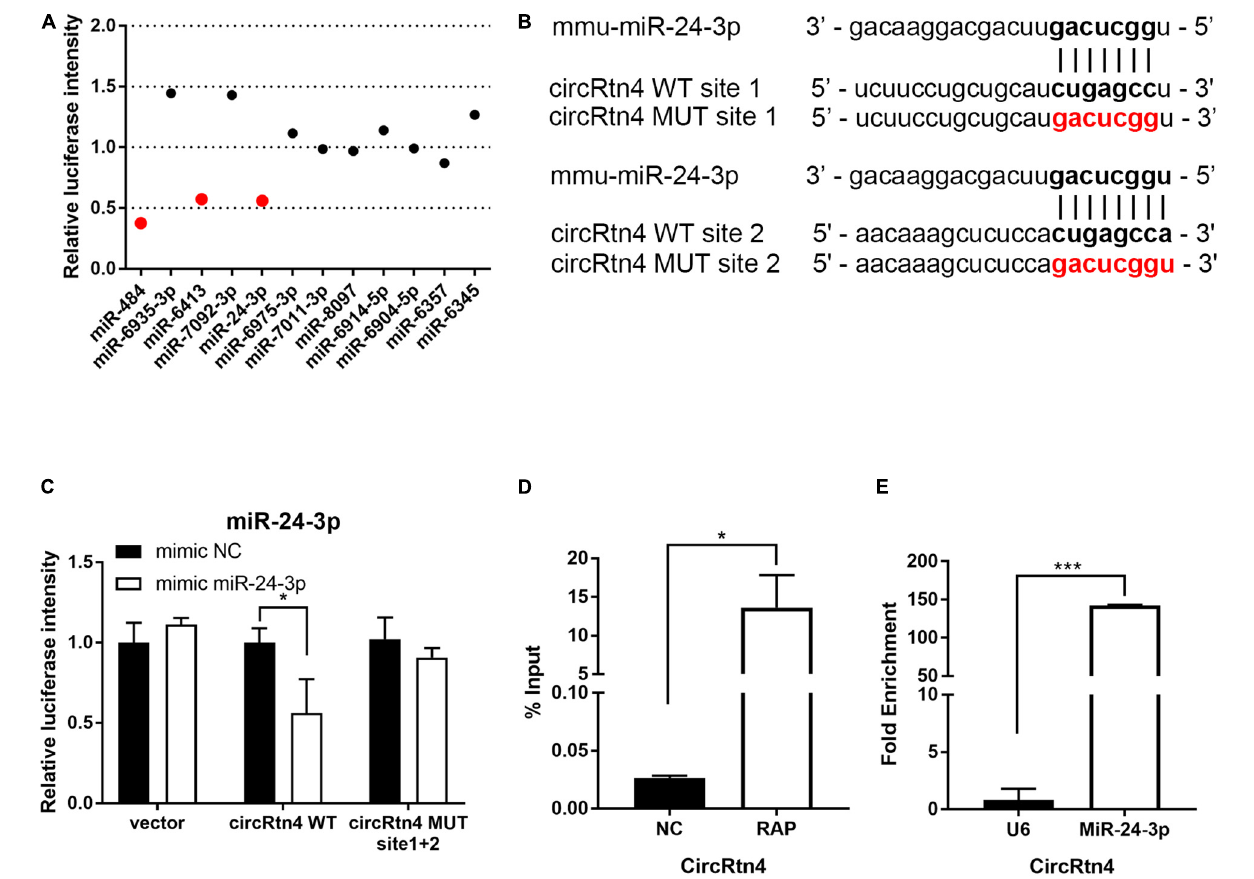
FIGURE 5 | CircRtn4 functions as a sponge of miR-24-3p. (A) 12 miRNAs candidates were screened by Dual-luciferase reporter assay. (B) The wild-type (WT) and mutated (MUT) circRtn4 binding sites with miR-24-3p were shown. (C) HEK-293T cells were cotransfected with psiCHECK TM -2-circRtn4-WT, psiCHECK TM -2-circRtn4-MUT or psiCHECK TM -2-control and miRNA mimics or miRNA negative control. Luciferase activity was detected with luciferase reporter assays. (D) The enrichment efficiency of circRtn4 probe was confirmed by qRT-PCR. (E) The enrichment of miR-24-3p in the circRtn4 RAP assay was detected by qRT-PCR. The results were shown as the mean ± SD (* p < 0.05, and *** p < 0.001 n =